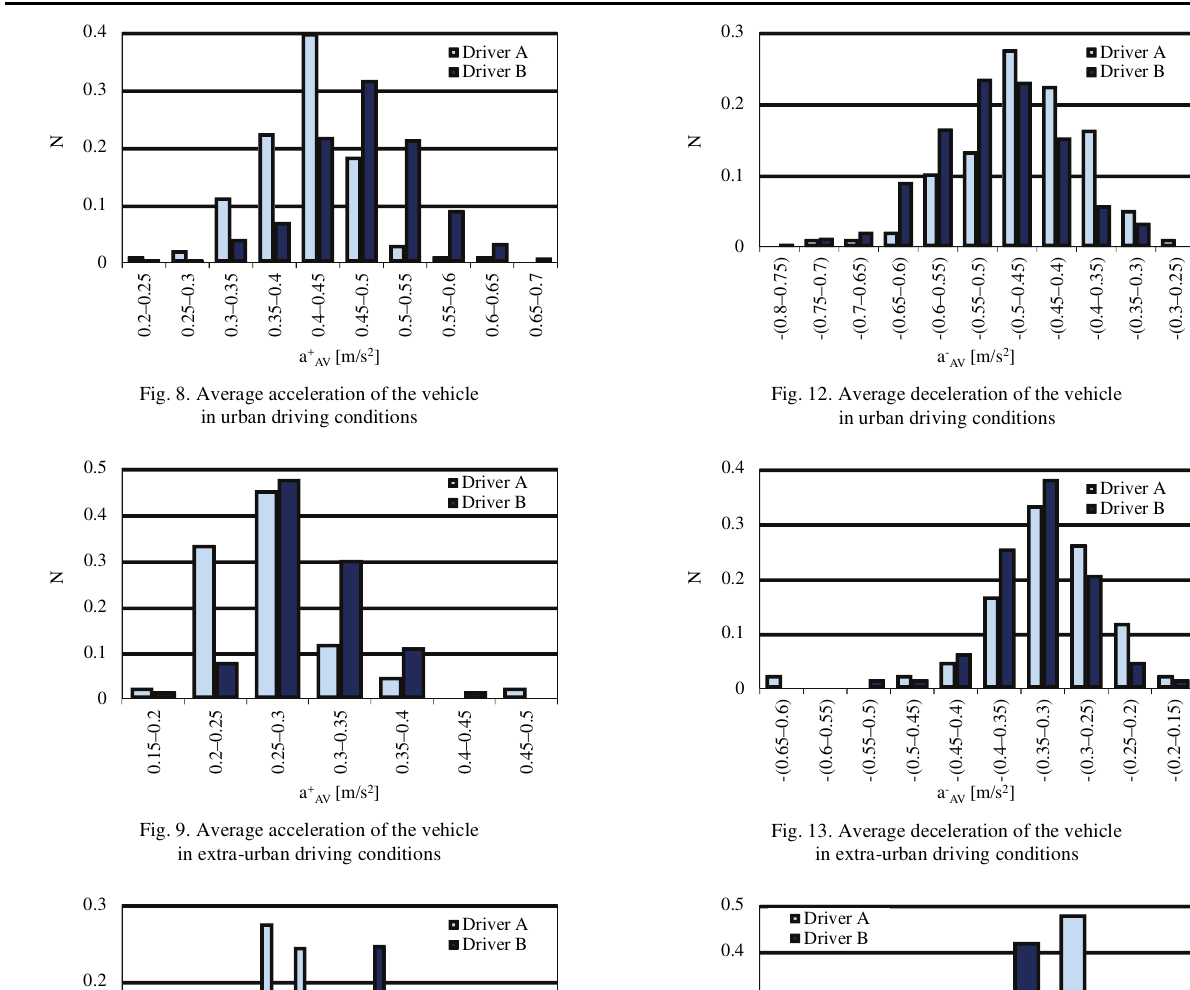
Fig. 9. Average acceleration of the vehicle in extra-urban driving conditions